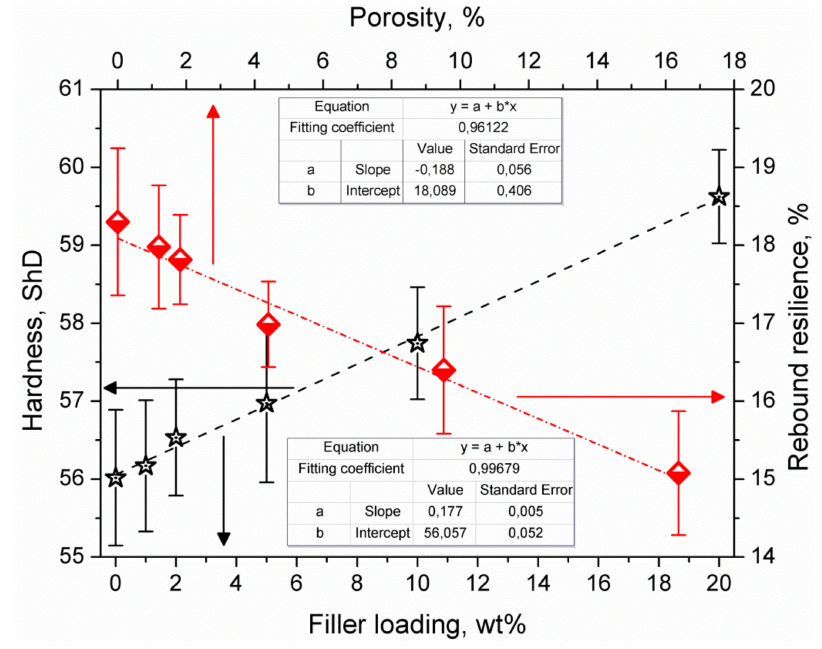
Figure 6. Impact of structural parameters of composites on their hardness and rebound